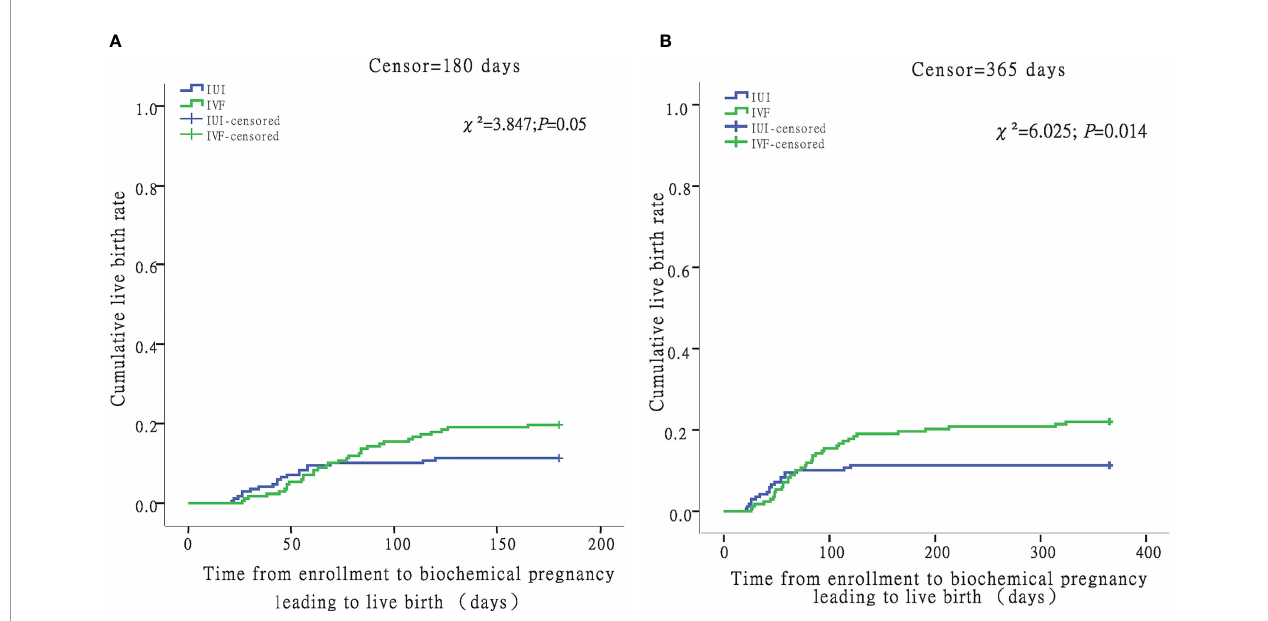
FIGURE 3 | Time from enrollment to biochemical pregnancy leading to live birth in the IUI and IVF groups. For women with livebirth, time to biochemical pregnancy leading to live birth was de fi ned as the number of days between enrollment and the date of hCG test. Women without livebirth were censored at 180 days (A) and 365 days (B)